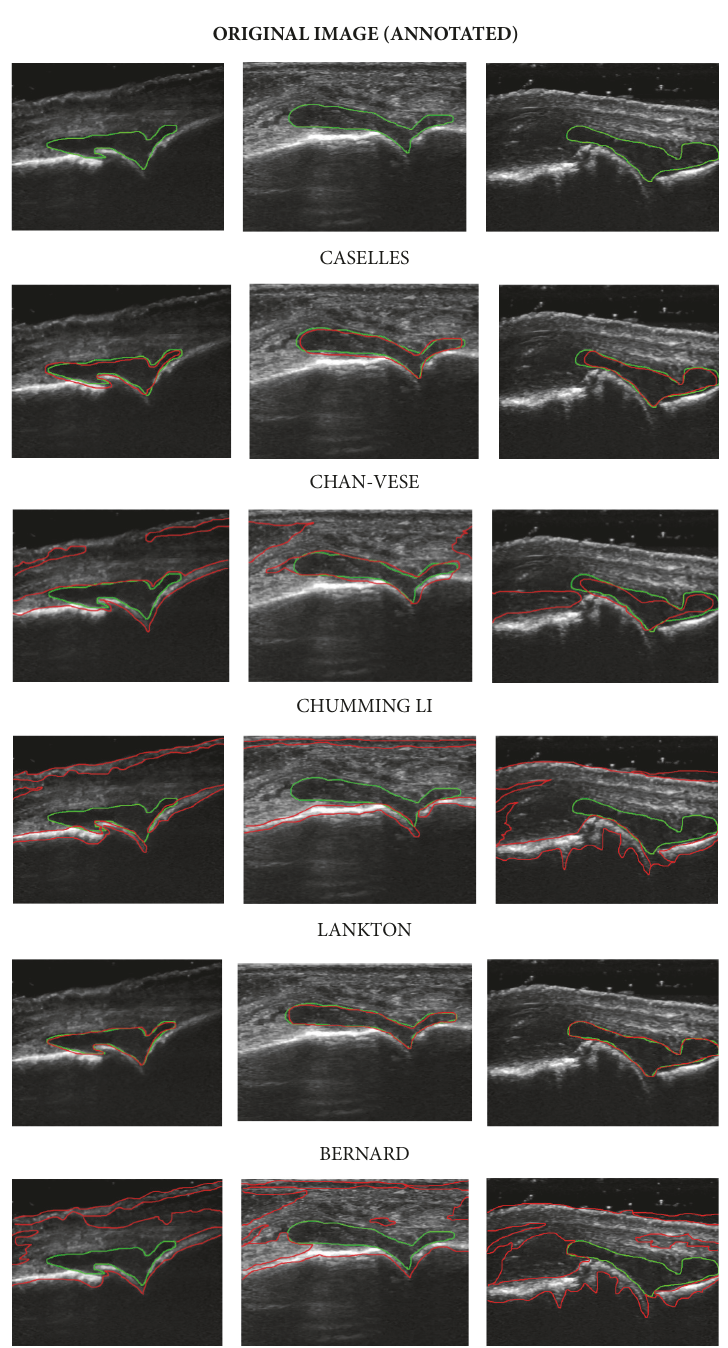
Figure 1: Different types of active contour segmentation